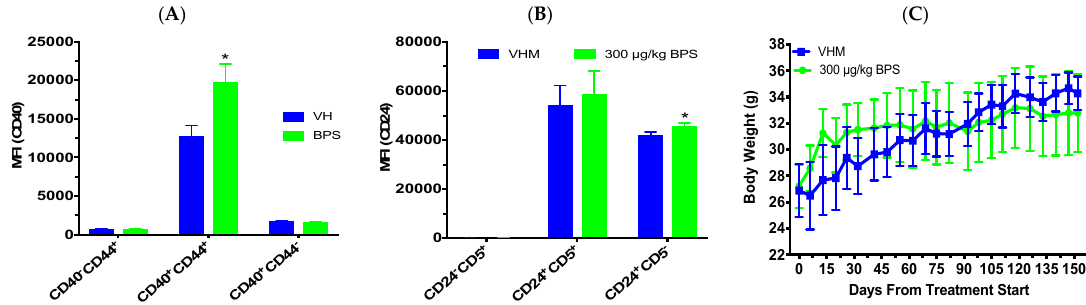
Figure 4. Immune cell populations and body weight in male NOD mice on the soy based diet. ( A ) The expression of CD40 by CD40 + CD44 + cells. ( B ) The expression of CD24 by CD24 + CD5 - cells. ( C ) Changes in body weight over time. The values are presented as mean ± SEM. *, p < 0.05. N = 5–6. VHM, vehicle males.